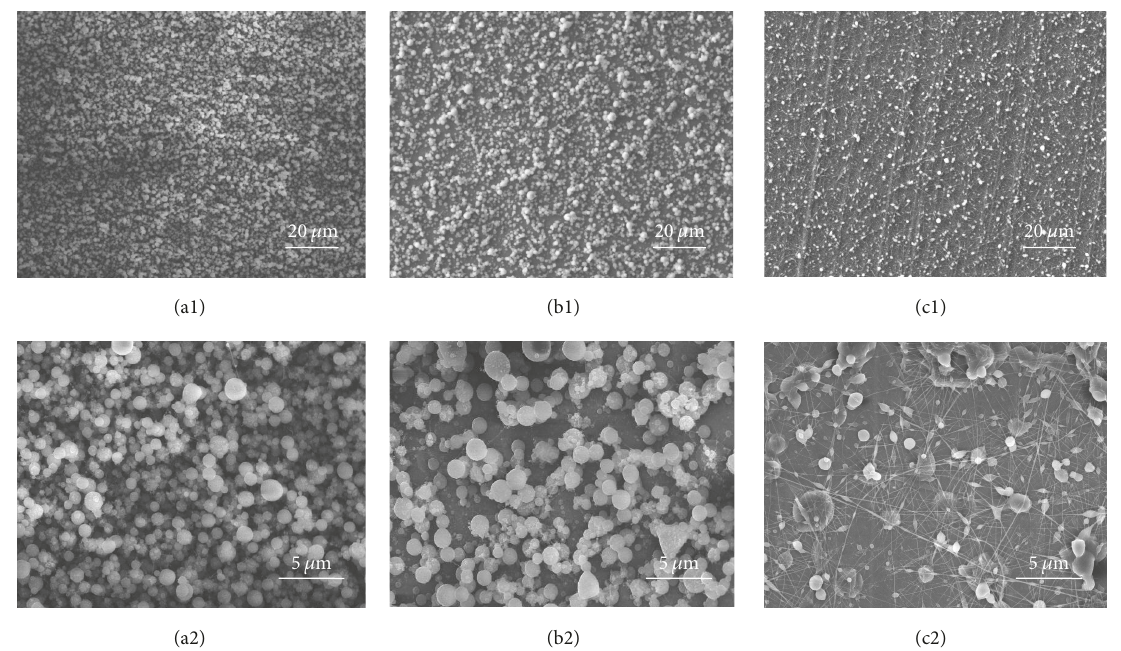
Figure 2: SEM observation of PLGA MPs in different concentration of PLGA: PLGA1 (a1, a2), PLGA2 (b1, b2), and PLGA3 (c1,